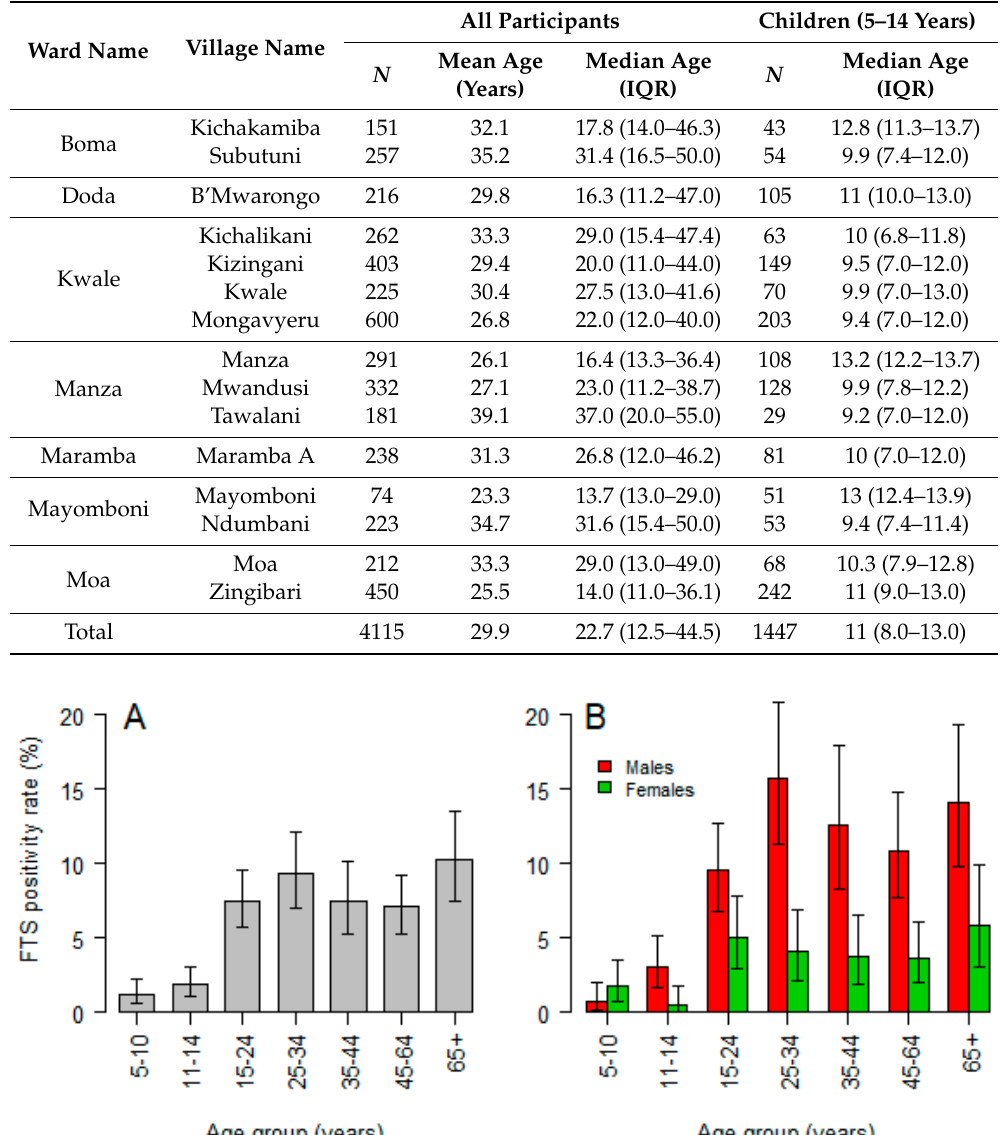
Table 1. Demographic characteristics of study participants.